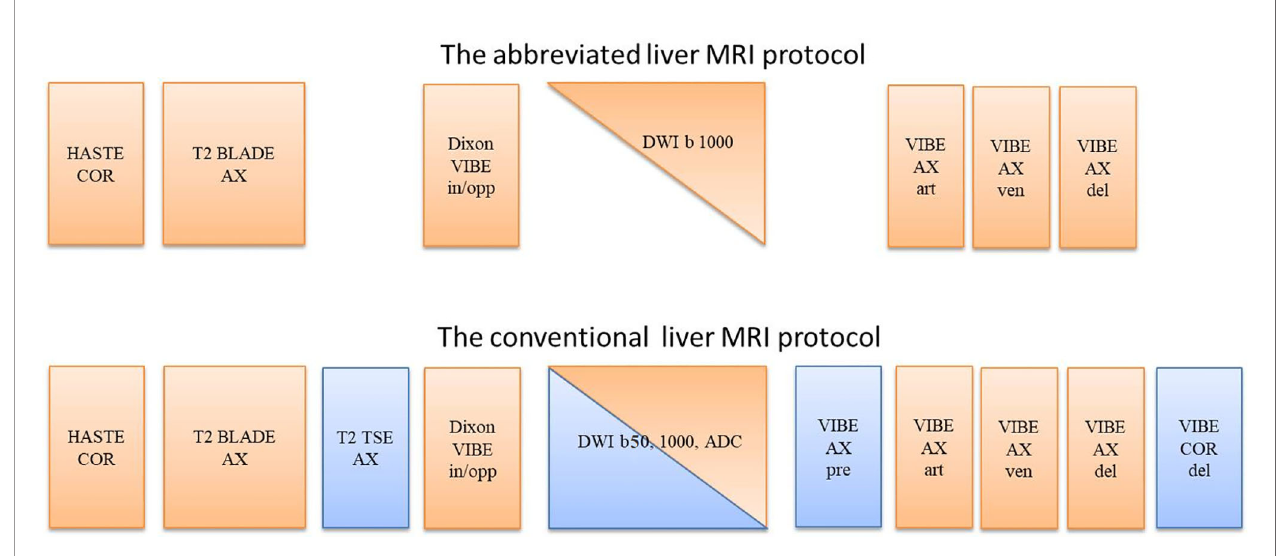
FIGURE 1 | The sequences used in the abbreviated fast liver MRI protocol and the conventional liver MRI protocol. COR, coronal; AX, axial; in/opp, in-phase and opposed-phase; art, arterial phase; ven, venous phase; del, delayed phase.